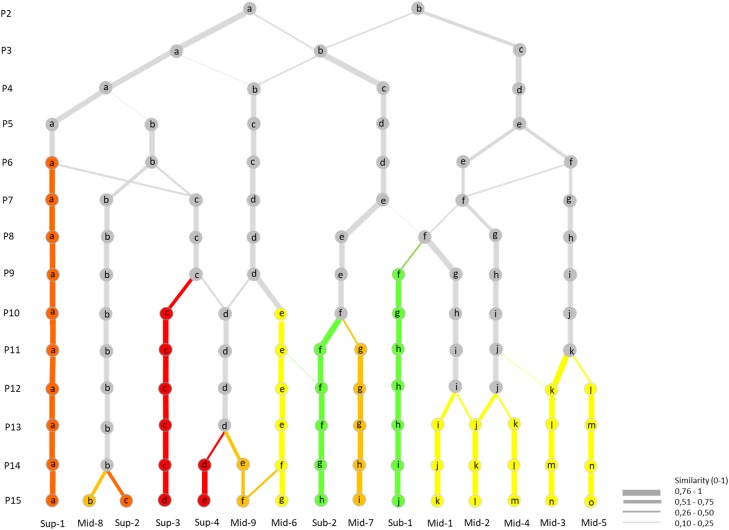
Hierarchical classification of the K-means successive partitions up to the optimal partition of 15 clusters, based on plot content similarities (0–1).Colour arrows show the appearance and maintaining of clusters through partitions without major plot content modifications (<0.5). In green: sub-páramo; in light yellow: mid-páramo; in dark yellow: upper mid-páramo; in orange: lower super-páramo; in red: upper super-páramo. Sub-1: Guaramacal sub-páramo, Sub-2: Widespread sub-páramo, Mid-1: Périja-Santa Marta mid-páramo, Mid-2: Eastern cordillera midpáramo, Mid-3: Central and western cordilleras mid-páramo, Mid-4: Mixed group of humid mid-páramo, Mid-5: Carchi mid-páramo, Mid-6: Ecuadorian mid-páramo, Mid-7: Venezuelan mid-páramo and lower superpáramo, Mid-8: The Nevados upper mid-páramo, Mid-9: The Ecuadorian upper mid-páramo, Sup-1: Lower humid super-páramo, Sup-2: The Nevados super-páramo, Sup-3: Upper humid super-páramo, Sup-4: Upper dry Ecuadorian super-páramo.